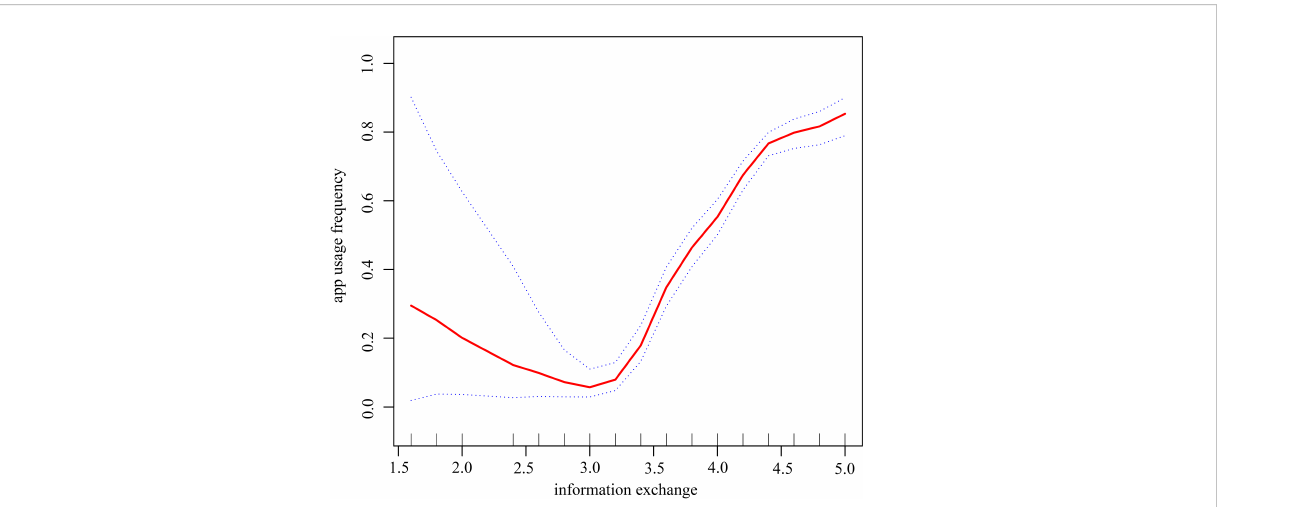
FIGURE 5 Analysis of the relationship between information exchange and app usage frequency in the online blood glucose management population by smoothing curve fi tting The red solid bars indicate a smooth curve fi t between information exchange and app usage frequency in the blood glucose management population, and the blue dashed strip indicates the 95% con fi dence interval of the fi t between information exchange and app usage frequency. Adjusting variables: sex; age; BMI; education; medical insurance; marital status; residence; family size; cohabitation with parents; glycosylated hemoglobin; SMBG Note:Divide into two groups according to the median of app usage frequency, less than 50% is the low usage frequency group of app and more than or equal to 50% is an app high usage frequency group.